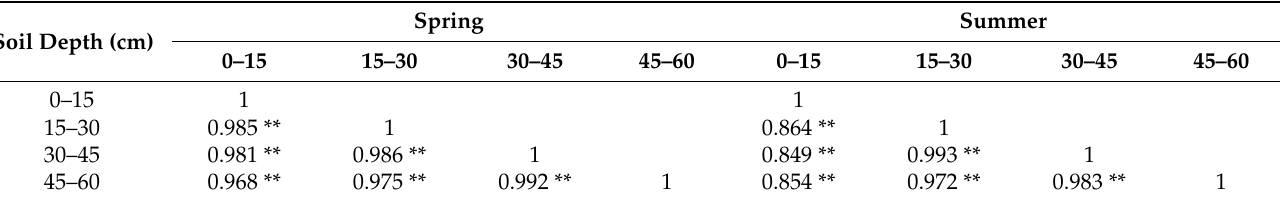
Table 4. Correlation coefficient matrix of soil salinity.